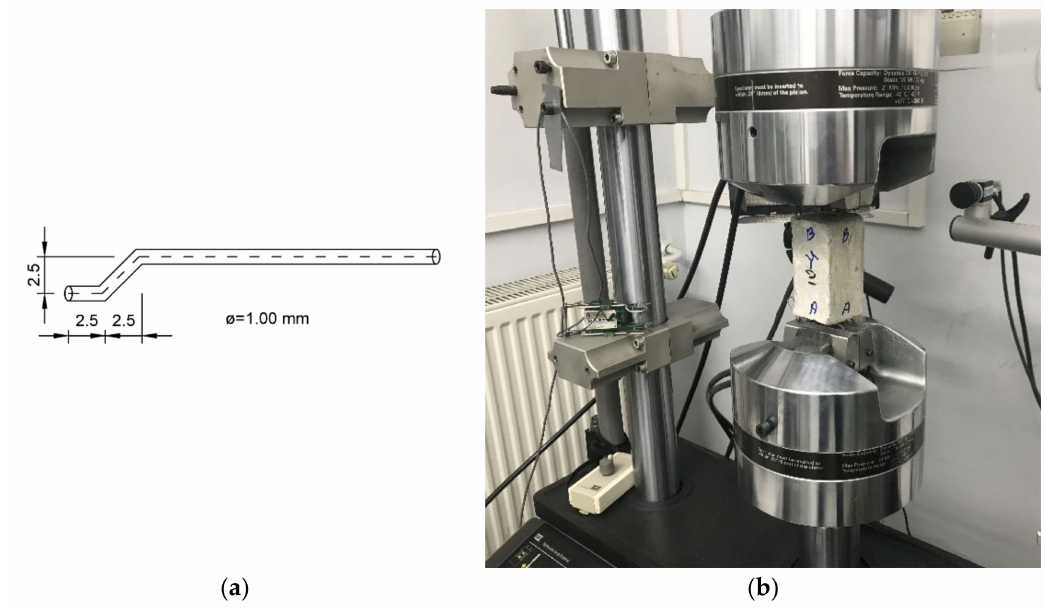
Figure 3. Laboratory testing of concrete specimens with fibers: ( a ) nominal fiber geometry; ( b ) MTS measurement system with test